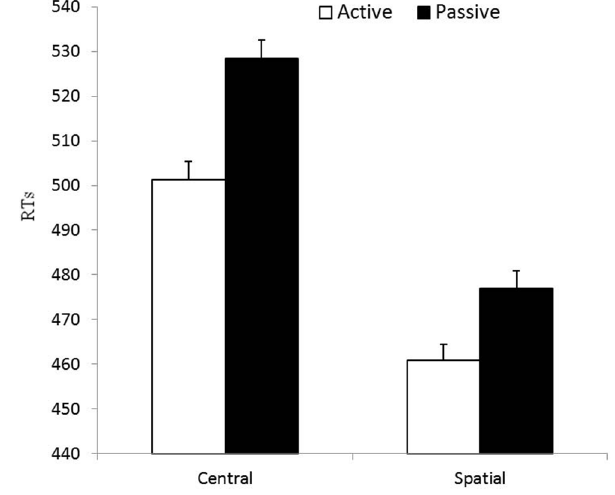
Figure 2. Attentional Network Effects. Difference scores in active and passive participants for RTs. The error bars represent one standard error of the mean.